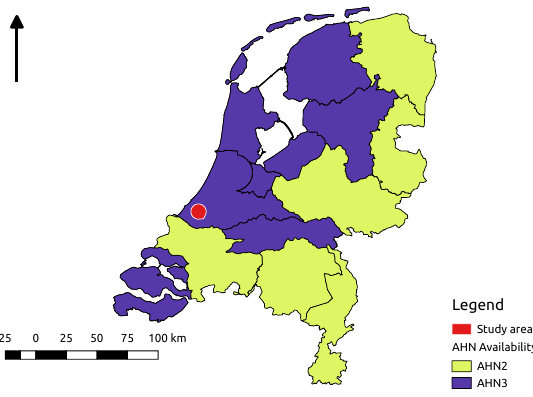
Figure 3. Map of the Netherlands, showing the availability of AHN2 and AHN3 respectively. Shown in red is the extent of the TerraSAR-X data available to this